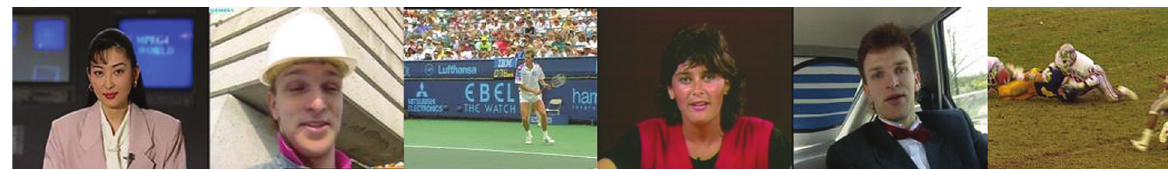
Figure 2: Snapshots of the training and validation content types.